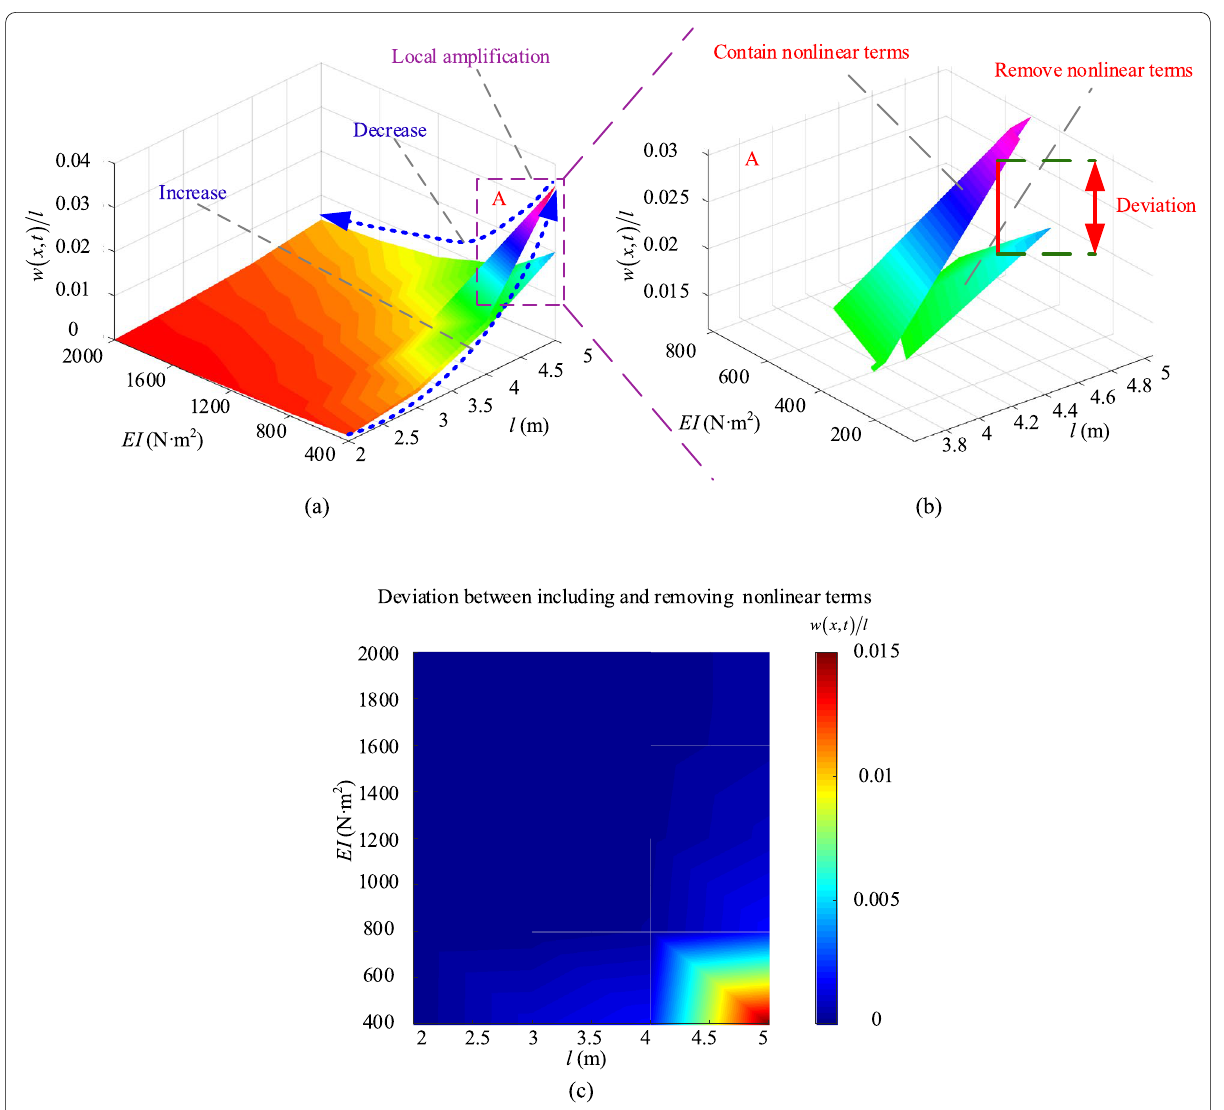
Figure 2 Deformation of flexible manipulators at high speed: ( a ) Relationship between deformability and length as well as flexural rigidity, ( b ) Partial enlarged view of ( a ), ( c ) Influence of nonlinear terms on